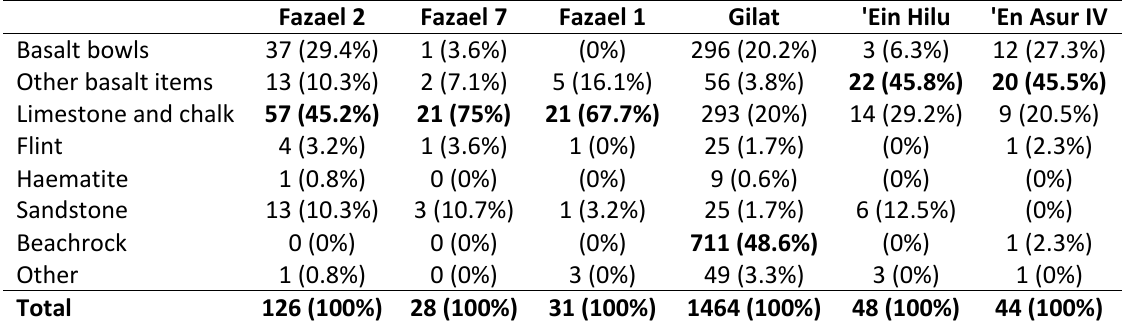
Table 1: The use of raw materials for utilitarian ground stone tools in various Late Chalcolithic sites (Rowan 2006; Rowan et al . 2006; Bar et al . 2008; Bar et al . 2014). The most common raw material in each site is in bold